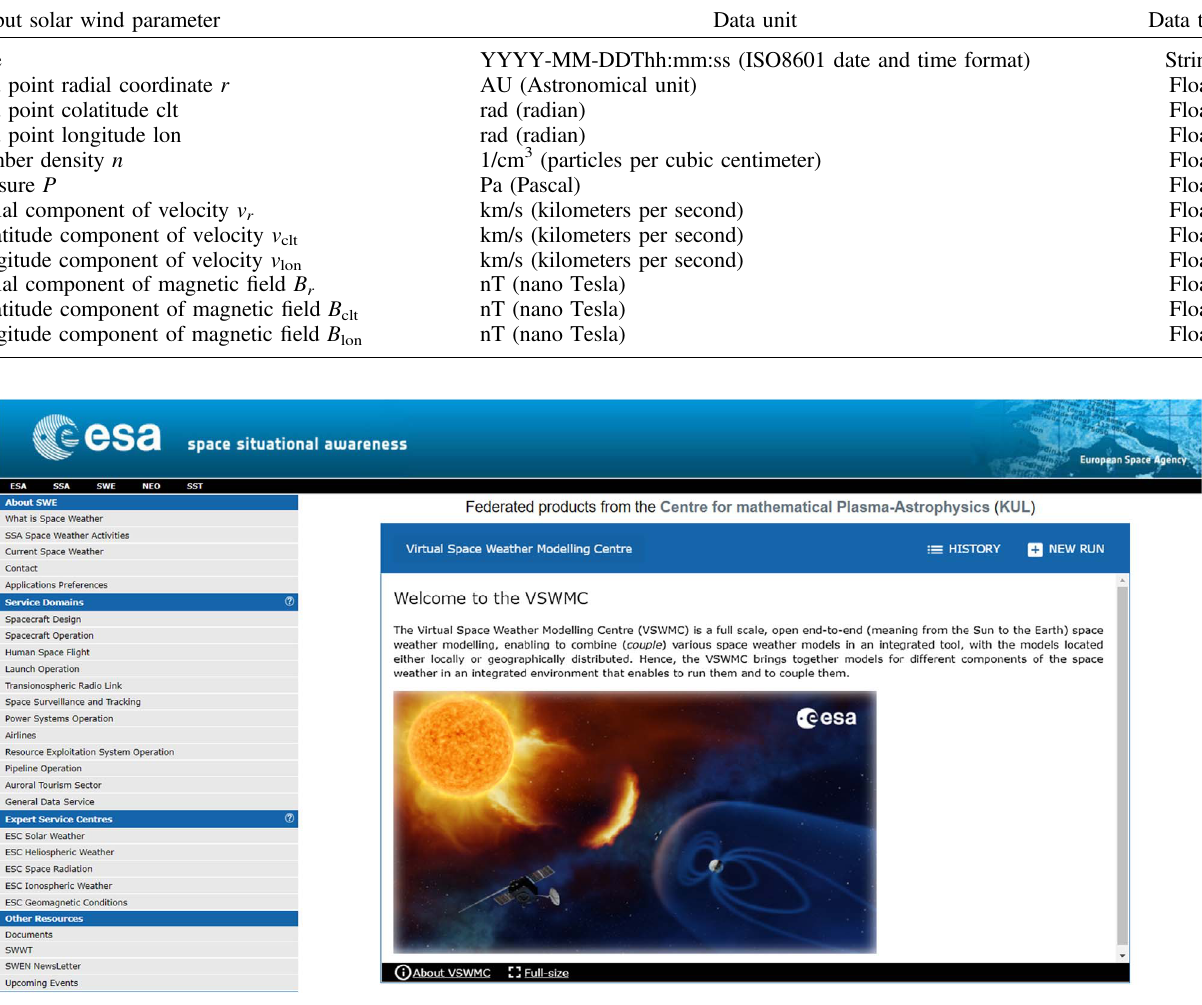
Fig. 6. Mock-up of screen shot of the VSWMC welcome page once integrated in the SSA SWE Portal providing an impression of how the integrated VSWMC will